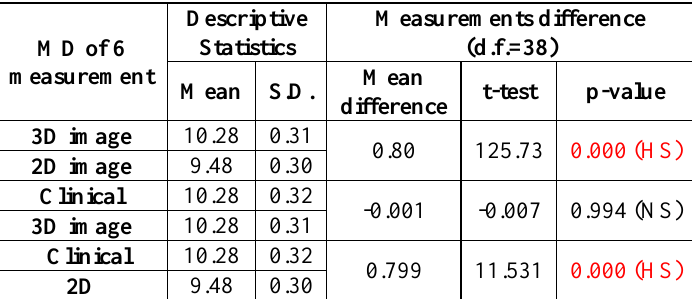
Table 4 : Descriptive statistics and measurements difference for the MD width of permanent mandibular first